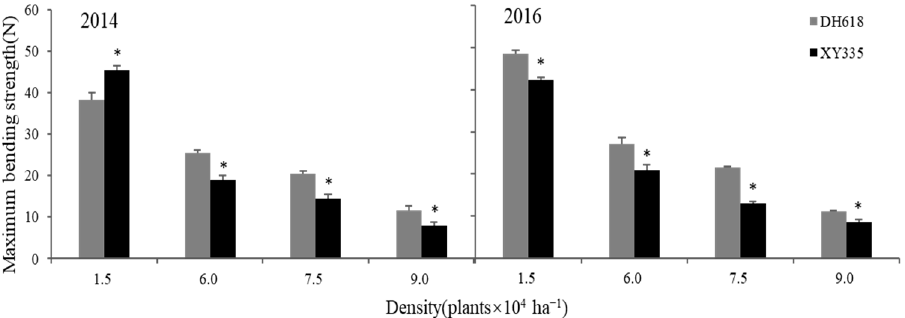
Figure 2. Maximum bending strength of DH618 and XY335 under different planting densities in 2014 and 2016. * Significant difference at p < 0.05. Table 1. Field maximum bending strength of DH618 and XY335 at different growth stages in 2014 and 2016.